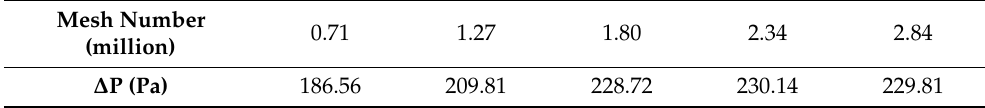
Table 1. Effect of the number of meshes on the average static pressure